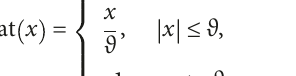
Figure 2: Accelerations under three guidance laws.